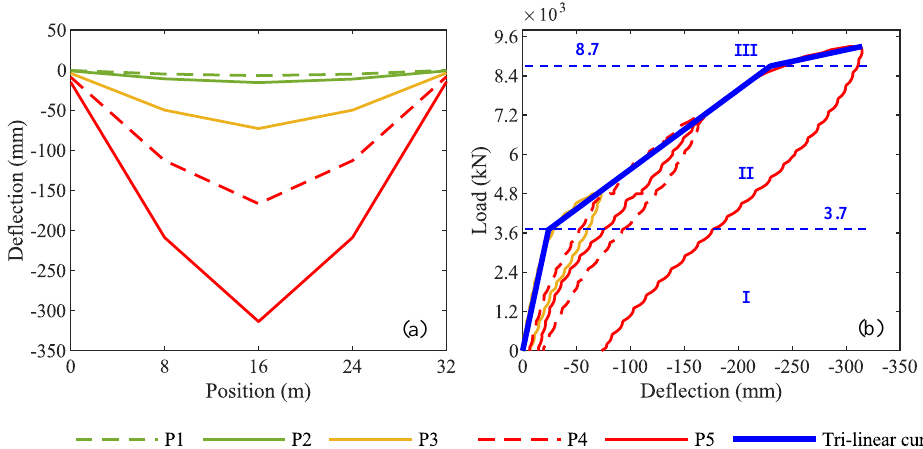
Figure 9. ( a ) Vertical displacements along girder T1 in the five loading phases; ( b ) load-deflection curve of girder T1 and its trilinear idealized flexural response.